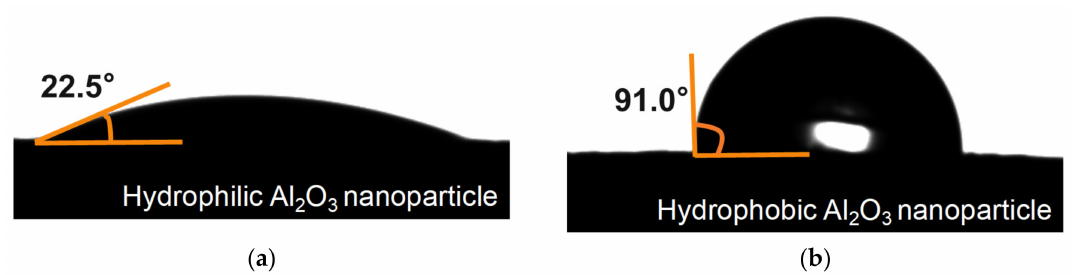
Figure 4. Contact angle of pure water on the ( a ) hydrophilic modified and ( b ) hydrophobic modified Al 2 O 3 nanoparticle powder surfaces.